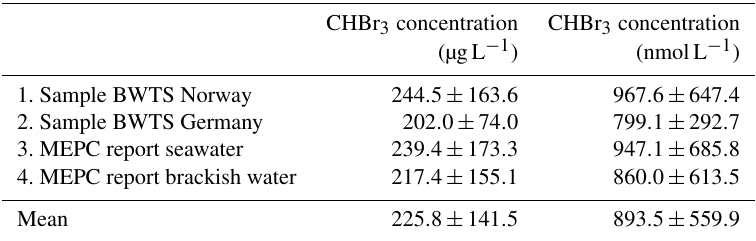
Table 1. Bromoform (CHBr 3 ) data from samples of undiluted ballast water given as an average and standard deviation (µgL − 1 ; nmolL − 1 ). Samples 1 and 2 are measurements from shipboard tests of a chlorination BWTS. Samples 3 and 4 are data from the IMO Marine Environ- mental Protection Committee (MEPC) reports on approval for different BWTSs using chemical